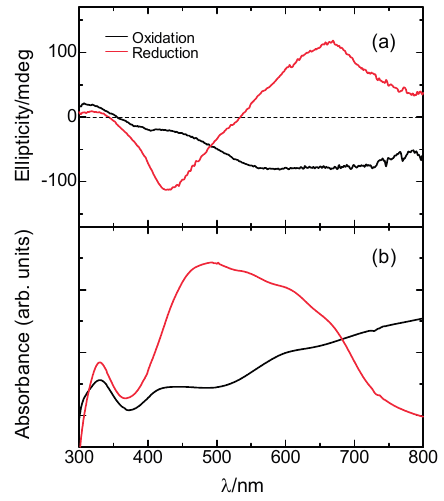
Figure 3. ( a ) Circular dichroism (CD) and ( b ) UV-Vis absorption spectra of the polymer